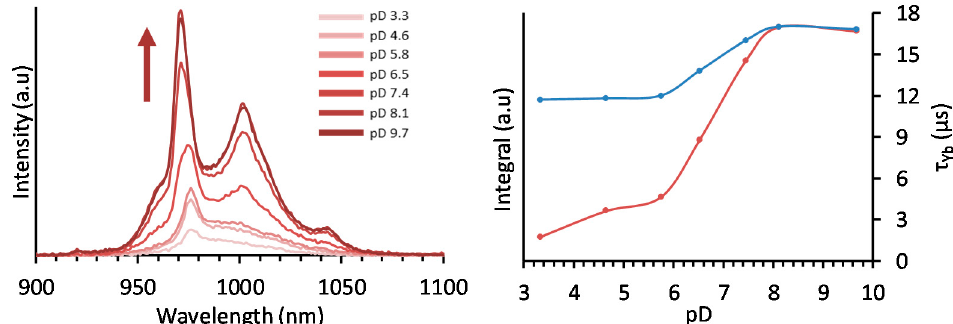
Figure 1. ( left ) Emission spectra of the YbL complex with an increase in the pD value in the D 2 O. The arrow indicates the increase of the pD. ( right ) Evolution of the emission integral (red) and the lifetime (blue) (YbL = 9.5 × 10 − 5 M, D 2 O), where λ exc = 270 nm.